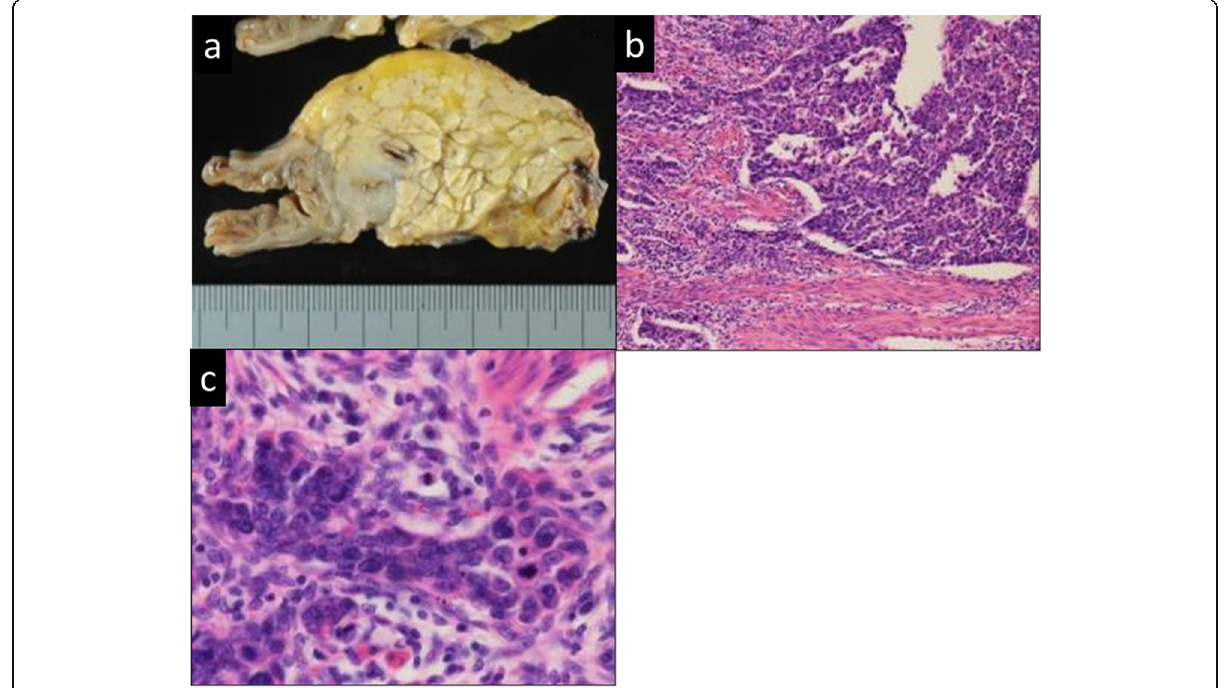
Fig. 5 Postoperative histopathological examinations. a Macroscopic findings. b Low-power field. c High-power field